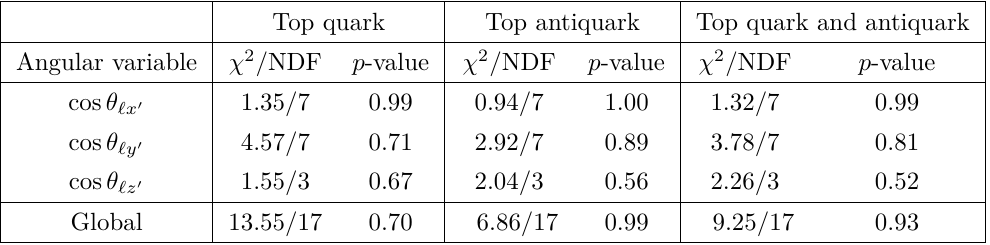
Table 6 . The χ 2 and p -value of the three unfolded angular distributions for the top-quark, for the top-antiquark and for both the top-quark and top-antiquark measurements. The numbers are computed by comparing the observed data with the Powheg Box + Pythia 8 SM predictions. The NDF corresponds to the number of bins of each angular distribution minus one. A global χ 2 and p -value for the three angular distributions are also